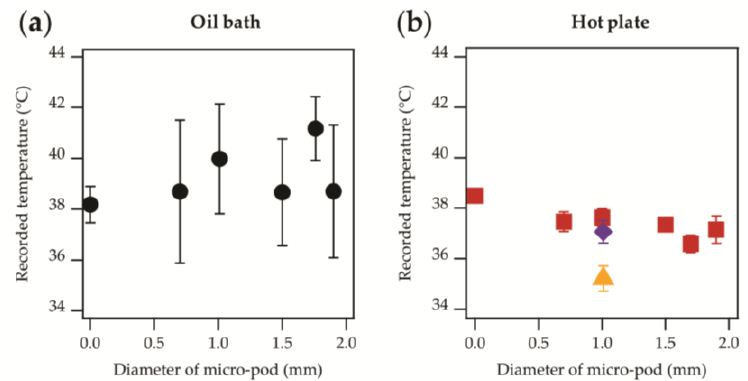
Figure 6. Averaged temperature values once an equilibrium was reached for samples with micro-pod diameters from 0 mm (unencapsulated) to 1.90 mm. ( a ) Data presented shows experiments where an oil bath was used ( ); ( b ) The samples were attached directly to a hotplate ( ). Data from samples that have included covering fibres; temperature-sensing yarn ( ), temperature-sensing yarn with an additional fibrous sheath ( ).